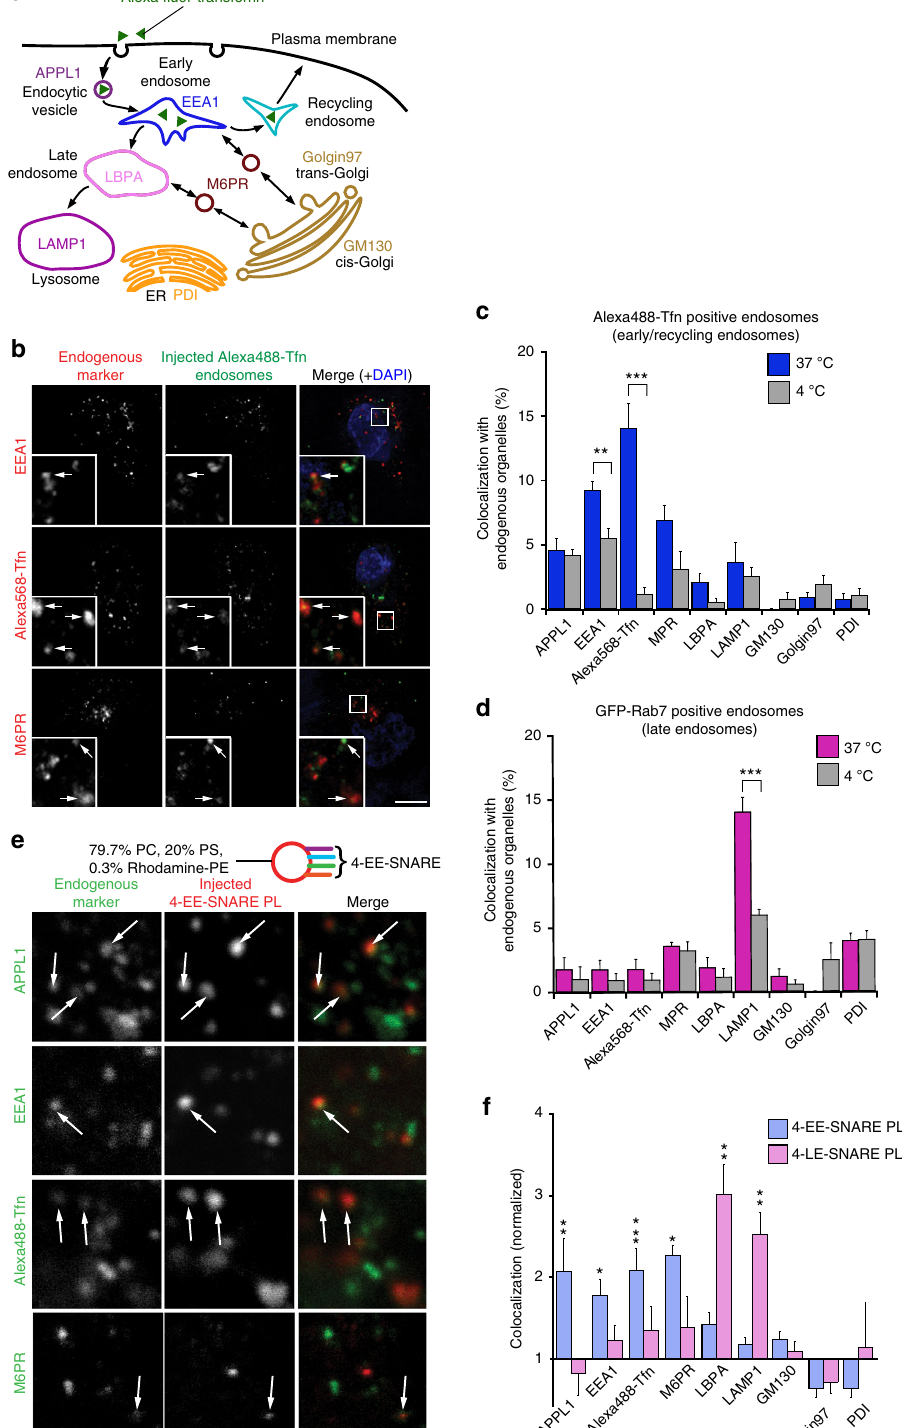
GFP-Rab7 to label late endosomes. Endosomes were then enriched using standard density gradient fractionation of post- nuclear supernatants (Supplementary Fig. 1a – d). Although the injected early/recycling endosomes are expected to contain at least some of these markers, the overlap between injected and endogenous EEA1/Tfn-positive endosomes, but not with other organelles, was much higher than in the 4 °C condition (Fig. 1b, c and Supplementary Fig. 2a), con fi rming our previous